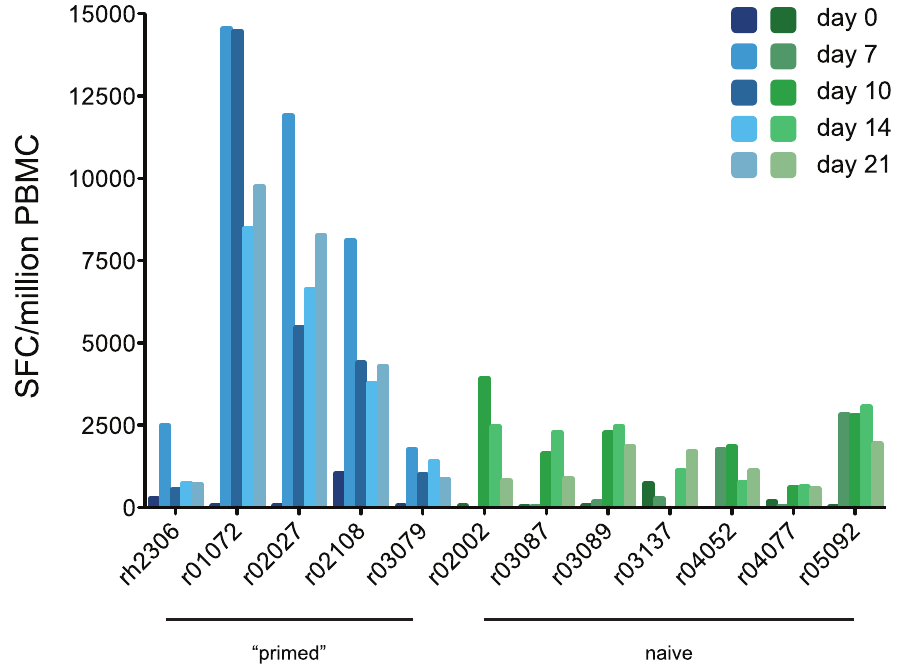
Figure 5. ‘‘Primed’’ animals mount stronger virus-specific T cell responses than naive animals after H1N1pdm challenge. T cell responses against the viral proteome were measured using IFN- c Elispot as described in Fig. 3. Blue bars, ‘‘primed’’ animals; Green bars, naive